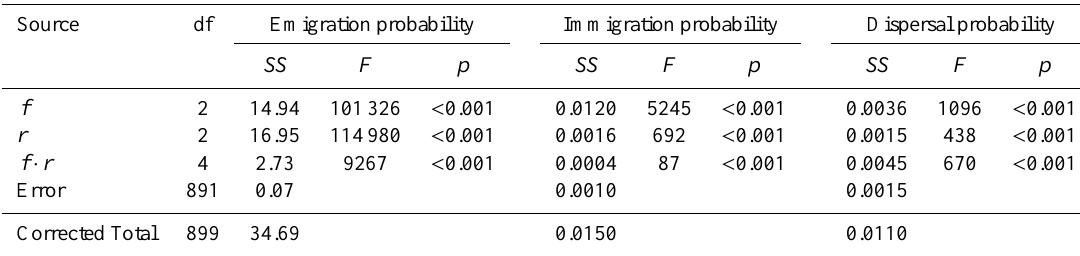
Table 2. Anova test results. E ff ect of summer habitat radius ( r ) and number of summer habitat fragments ( f ) and their interaction on emigration probability, immigration probability and dispersal